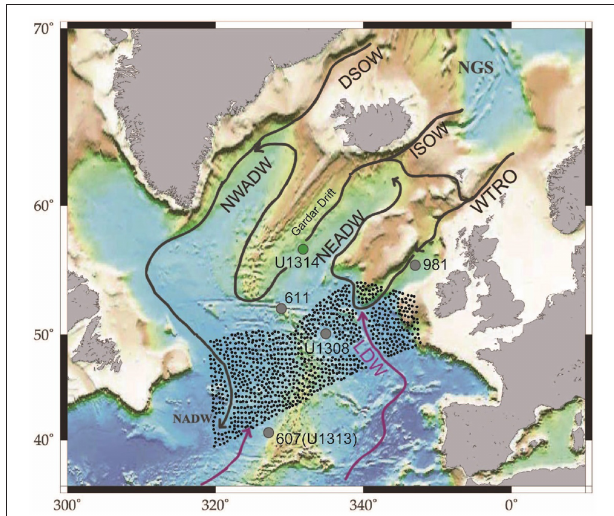
FIGURE 1 | Map of study site. Location of IODP Site U1314 and other sites discussed in the text plotted on bathymetric map of the northern North Atlantic [modified after Raymo et al. (2004)]. Paths of major deep water flows are indicated by arrows. Abbreviations not defined in text are: DSOW, Denmark Strait Overflow Water; NWADW, Northwest Atlantic Deep Water; NEADW, Northeast Atlantic Deep Water; NGS, Norwegian-Greenland Sea. The stippled area represents the Ruddiman IRD belt (Ruddiman, 1977), plotted after Hemming